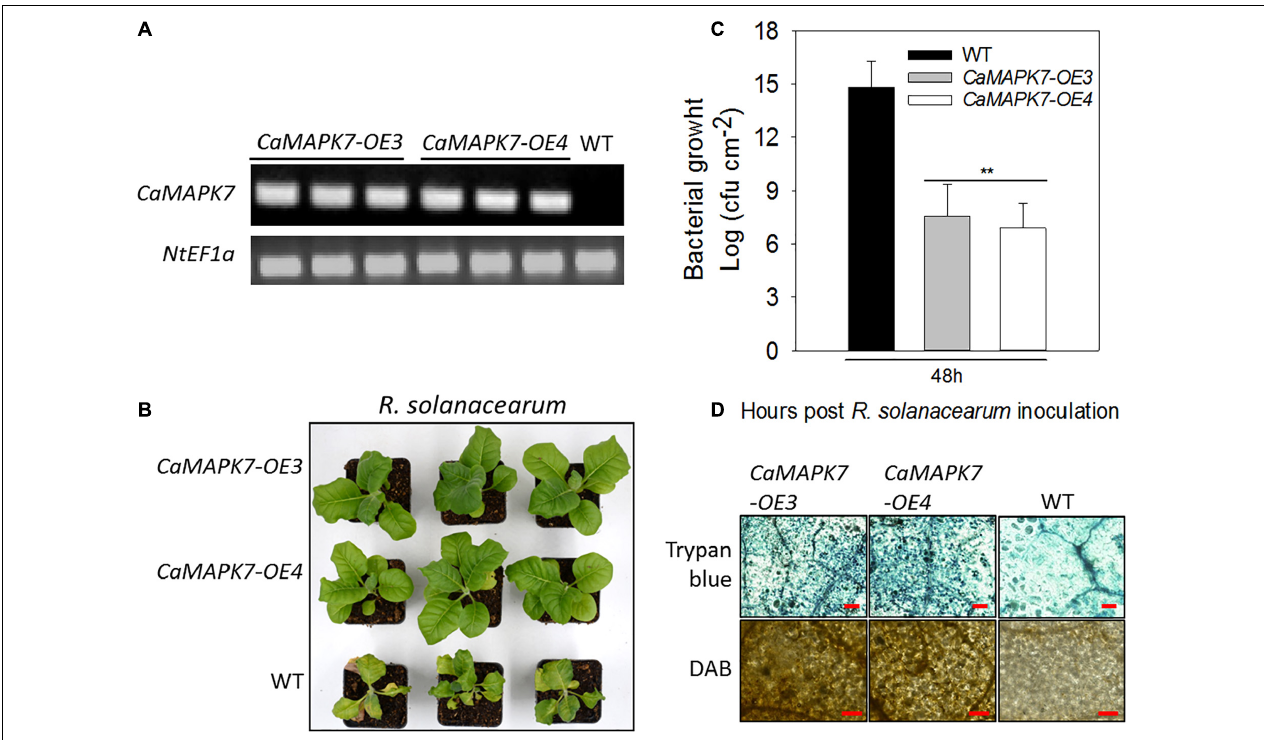
FIGURE 6 | Transgenic T3 tobacco plants ectopically overexpressing CaMAPK7 exhibit enhanced resistance to Ralstonia solanacearum . (A) Transcript accumulation of CaMAPK7 in CaMAPK7-OX lines (#3 and #4) and WT detected by semi-quantitative PCR. (B) The disease phenotype of CaMAPK7-OX lines and WT 10 dpi with R. solanacearum strain FJC100301 in the plant roots. (C) The growth of R. solanacearum in leaves of CaMAPK7-OX lines and WT at 48 h post- R. solanacearum inoculation. Values are average CFU based on three biological replicates. Asterisk indicates significant differences determined by the Fisher’s protected LSD test (** p < 0.01). (D) HR-like cell death and H 2 O 2 accumulation detected in CaMAPK7-OX lines and WT induced by R. solanacearum infection. Bar = 500 µ m. dpi, days post-inoculation; HR, hypersensitive response; WT, wild-type.